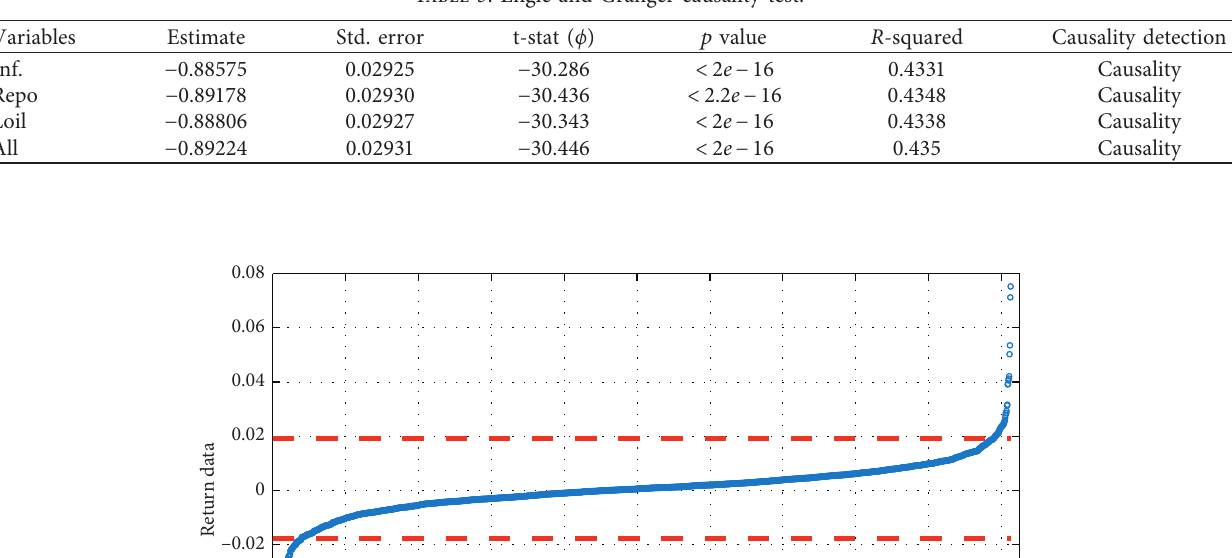
Table 3: Engle and Granger causality test.